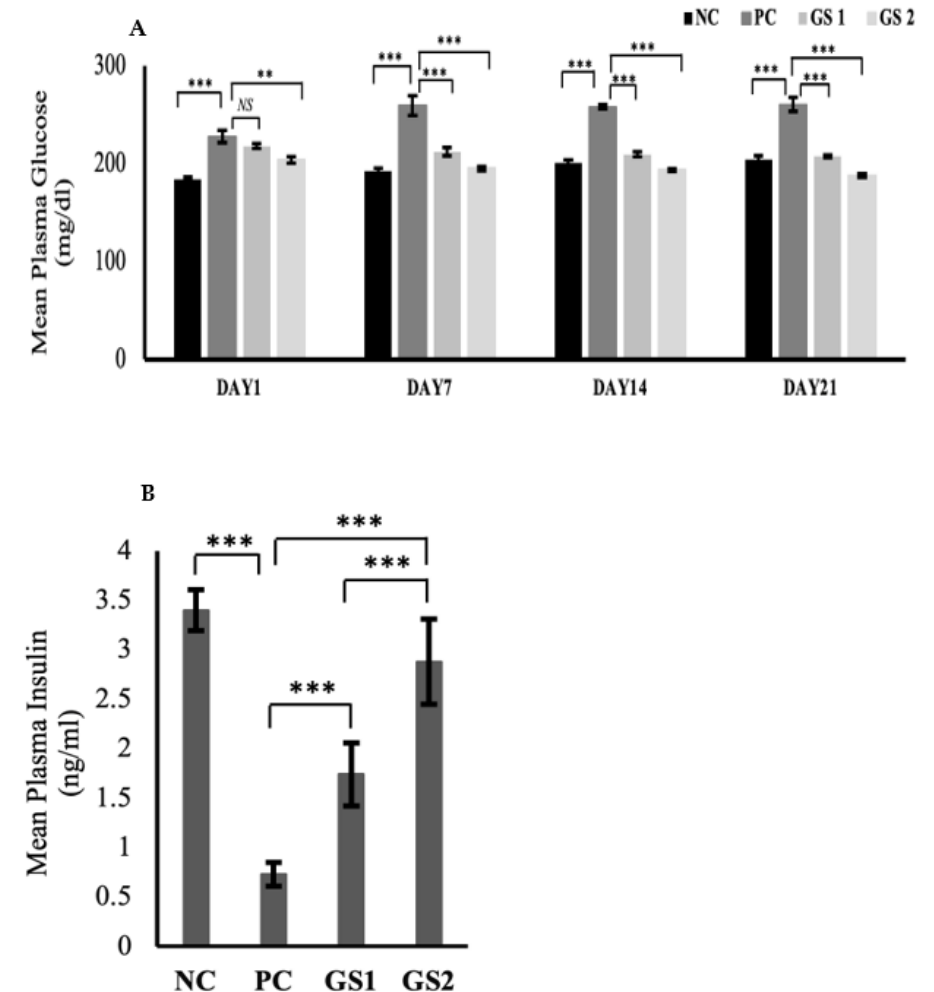
Figure 1. Mean values of serum glucose (mg/dl) ( A ) and plasma insulin (ng/mL) ( B ) levels in different treatment groups. Negative control (NC), Positive control (PC), Gymnema sylvestre 250 mg (GS1), Gymnema sylvestre 500 mg (GS2). NS : non-significant , ( ** ): p ≥ 0.01, ( *** ): p ≥ 0.001.